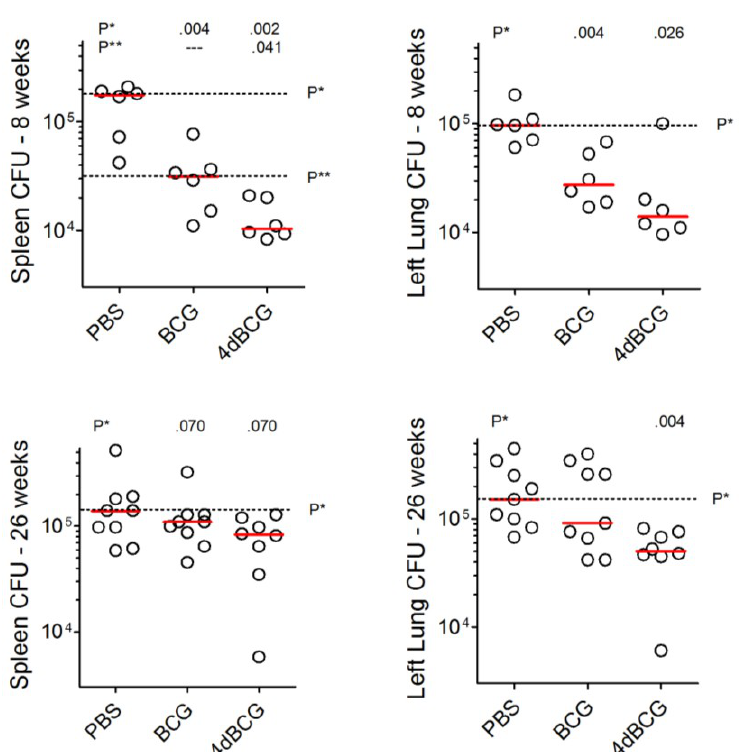
Figure 3. Titer of M. tuberculosis challenge bacilli in the spleens and left lungs of C57Bl/6 mice. Mice received aerosol challenge with 100 cfu of M. tuberculosis strain Erdman S-1. The whole spleens and left lungs were assessed for cfu titer while the right lungs were processed for histopathology as shown in Figures 4–7. The individual data points (circles) and median (bar) for each vaccination arm are shown at 8 weeks (top, six mice per vaccination arm) and 26 weeks (bottom, eight or nine mice per vaccination arm) post-challenge. The dotted lines extend the bar representing the median value of the PBS-vaccinated and BCG-vaccinated groups and are marked P* and P**, respectively. Analysis of spleen and lung results at 8 weeks and lung results at 26 weeks by 1 way ANOVA demonstrated that the median values of the groups varied significantly by Kruskal-Wallis test. The groups were also compared using the Mann-Whitney test and values in the row labeled P* above the panel indicate the comparison of each vaccinated group against the phosphate-buffered saline (PBS) group. The values in the row labeled P** indicate the comparison of the 4dBCG and BCG